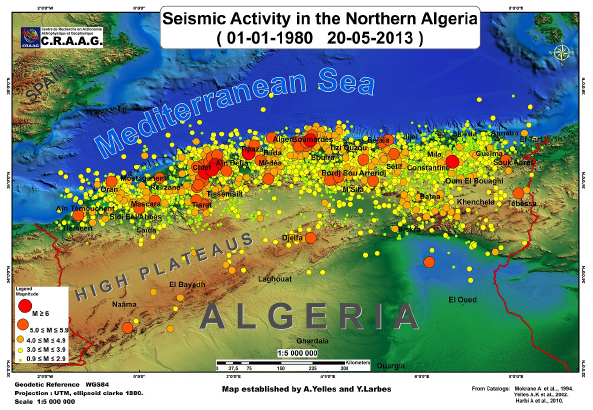
Fig. 1. Seismic Activity in the Northern Algeria (from 1 January 1980 to 20 May